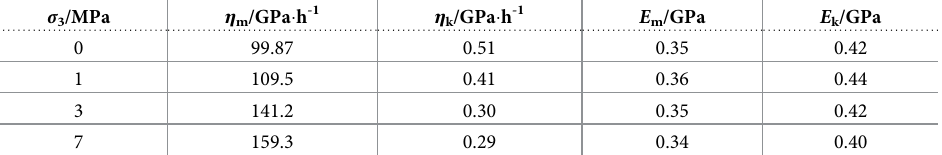
Table 4. Fitted creep parameters of mudstone.